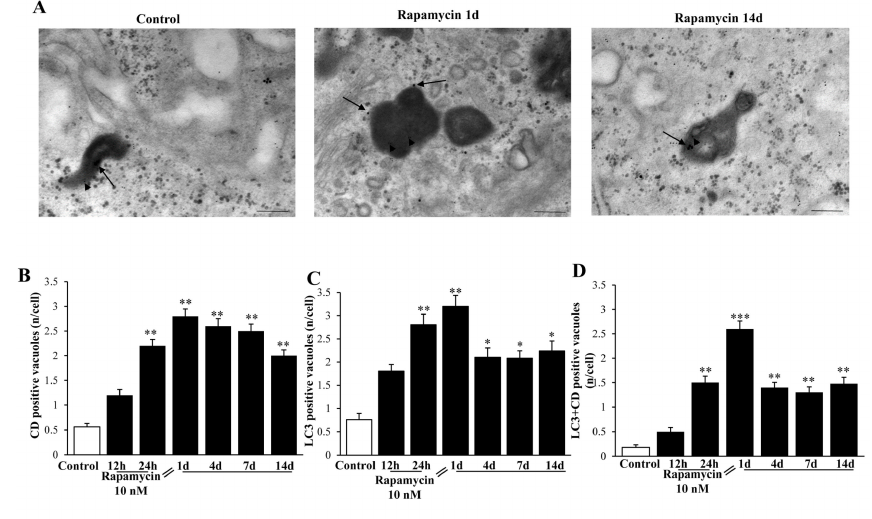
Figure 19. Rapamycin increases LC3 + Cathepsin-D co-immune-stained vacuoles within U87MG cells. ( A ) Representative TEM micrographs show LC3 + Cathepsin-D co-immune-stained vacuoles